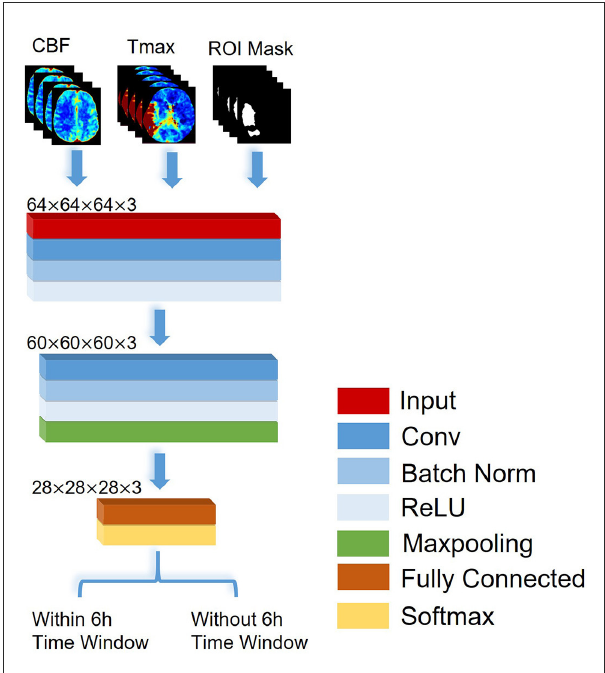
FIGURE1 The architecture of the CNN proposed to identify patients with AIS within a 6-h window for the treatment of EVT.